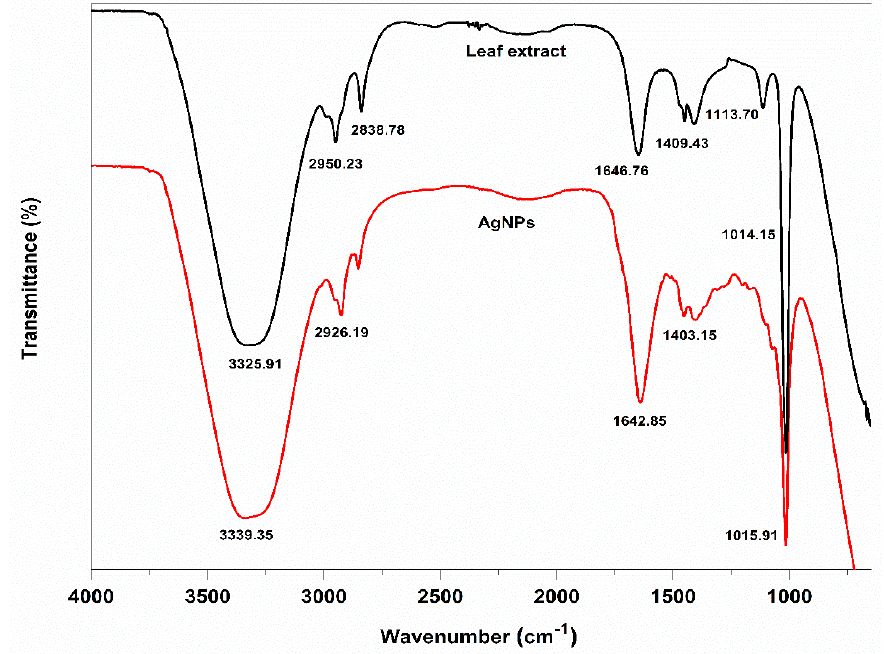
Figure 6. Comparative FTIR spectra of Fenugreek leaf extract (FLE) and biosynthesized silver nanoparticles (FL ‐ AgNPs).